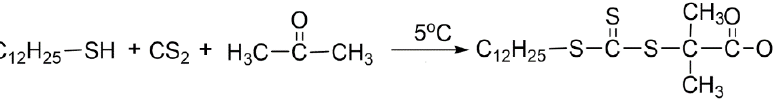
Figure 1. The FTIR spectrum of chain transfer agent, DMPA.